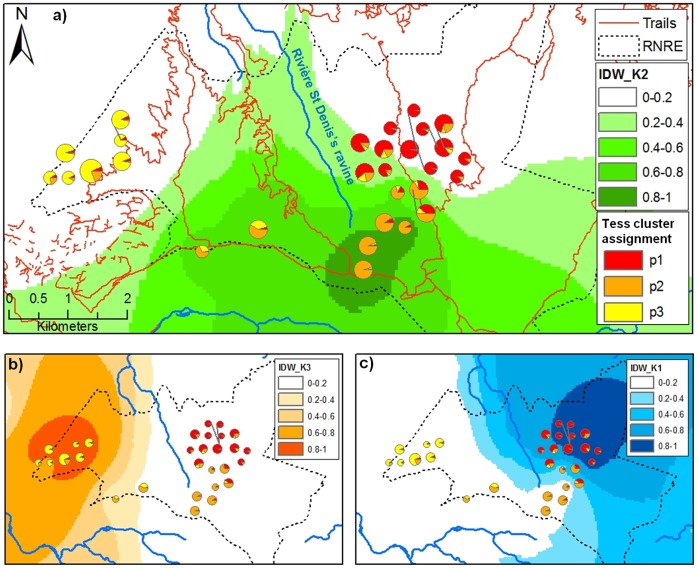
Membership of genetic clusters estimates using TESS.The size of the pie charts is proportional to the number of sampled individuals (between one and three individuals). The colors indicate the average membership coefficients of each individual to each of the three clusters uncovered by Tess. The gradients illustrate the interpolated (IDW) membership coefficients of the cluster K3 (a), K2 (b) and K1 (c) (see text for details).